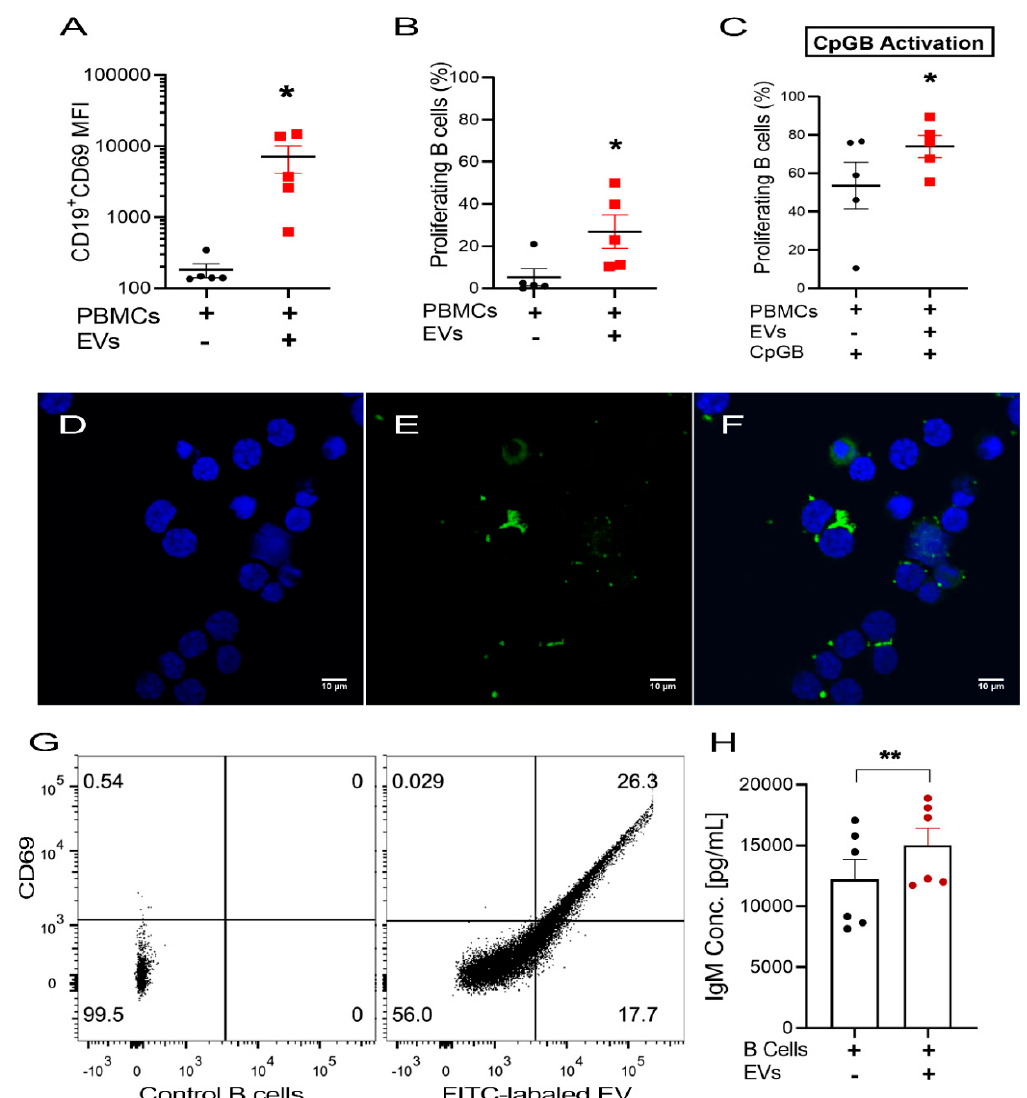
Figure 4. The effect of USCs EVs on B cells; ( A ) CD69 (early activation marker) expression on B cells population showing increased expression with EV co-culture. ( B , C ) Proliferation assay of the % proliferating B cells as the result of EVs co-culture in ( B ) resting and ( C ) CpGB–stimulated conditions showing significant enhancement of proliferation in both conditions in response to EV co-culture ( n = 5). ( D – F ) Confocal microscopy images of DAPI (4 ′ ,6-diamidino-2-phenylindole) stained purified B cells ( D ) co-cultured with labeled EVs ( E ) for 24 h, ( F ) showing the presence of labeled EVs inside the cytoplasm and in aggregates attached to the cell surface (Mic. Magnification ×600, scale bar = 10 μ m). ( G ) A representative sample of flow cytometry analysis of CD69 + B cell population for FITC labeled EVs uptake versus control. ( H ) Antibody analysis of the supernatant showing a significant increase of IgM with EV co-culture ( n = 6). Values are presented as Mean ± SEM, p –values were determined by Paired Student’s t– tests. * p < 0.05, ** p < 0.01.